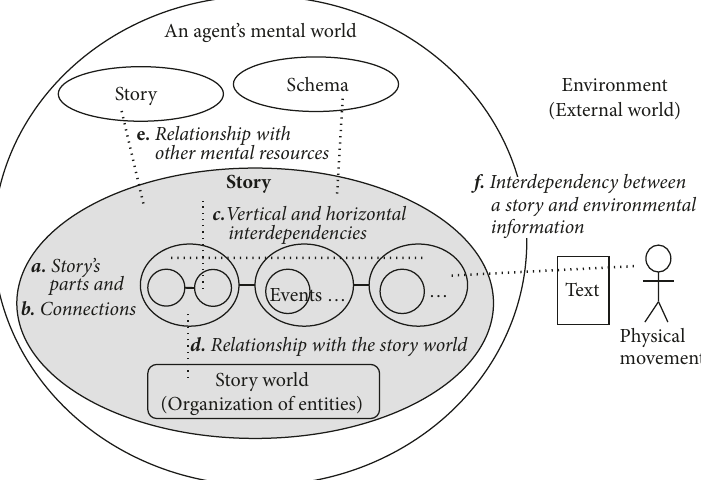
Figure 5: Structural complexity of a story. Dot-lines represent interdependencies or relationships among a story’s parts and other mental objects.